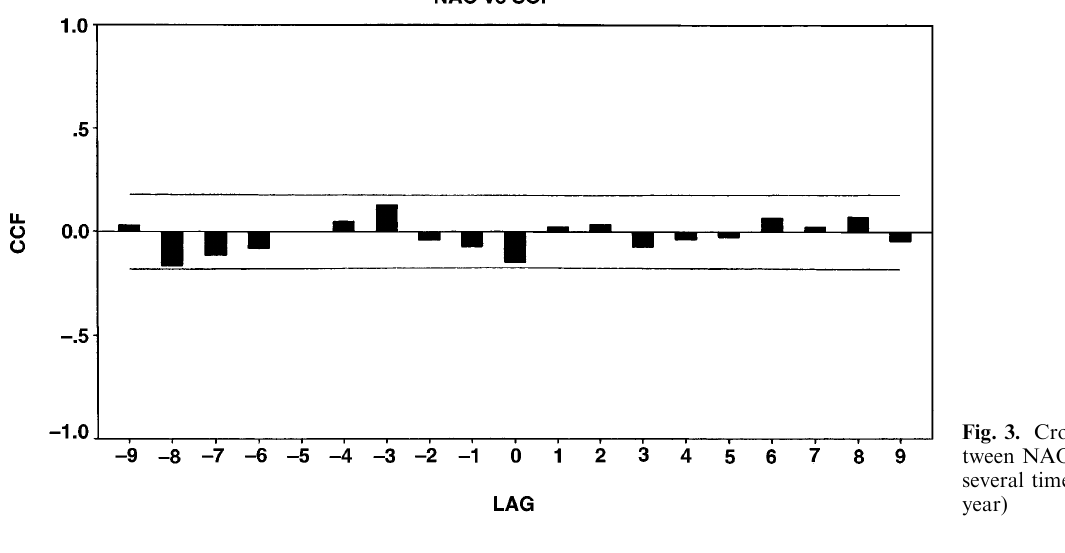
Fig. 3. Cross-correlations be- tween NAO and SO indices for several time lags (one lag = one